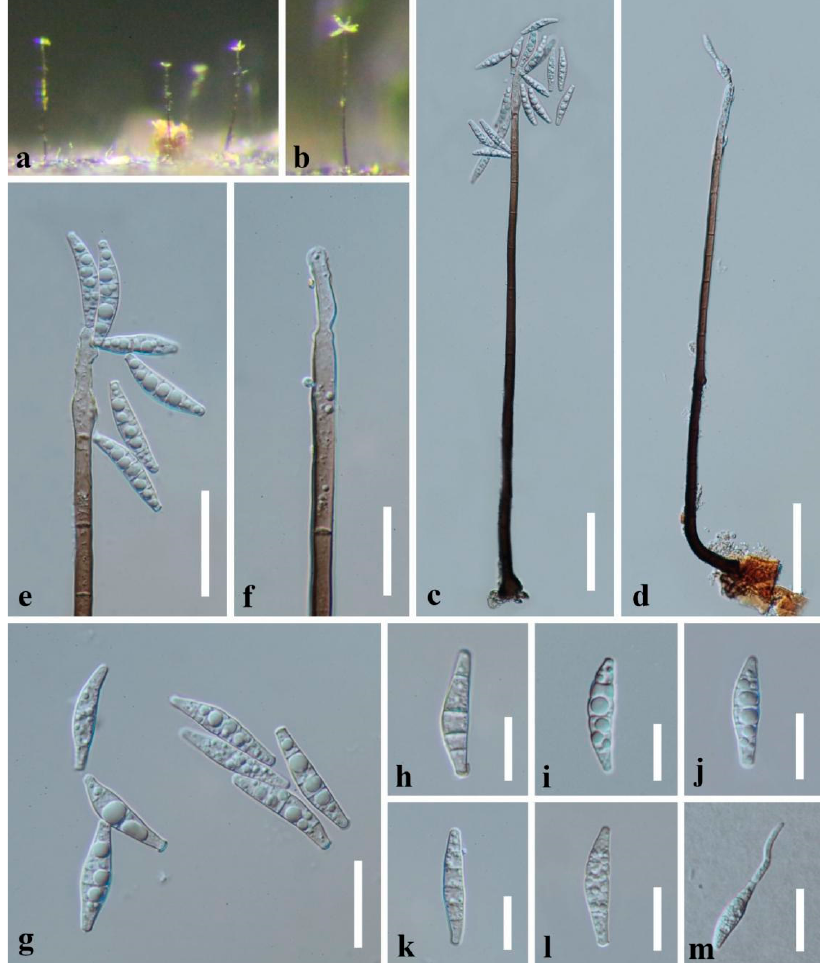
Figure 3. Paramirandina cymbiformis (HKAS 112619, holotype ) ( a , b ) Colony on wood. ( c , d ) Conidio- phores with conidia. ( e ) Conidiogenous cell with conidia. ( f ) Conidiogenous cell. ( g – l ) Conidia. ( m ) Germinated conidium. Scale bars: ( c , d ) = 50 μ m, ( e ) = 30 μ m, ( f , g , m ) = 20 μ m, ( h – l ) = 15 μ m.